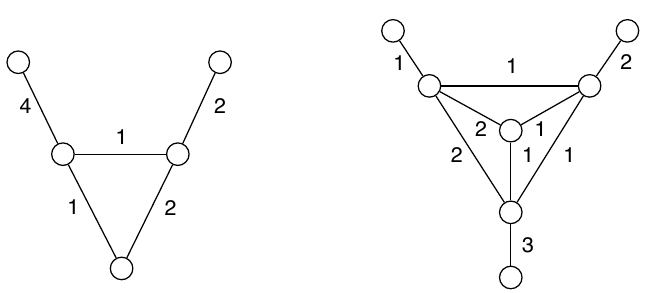
-antimagic labeling of H k